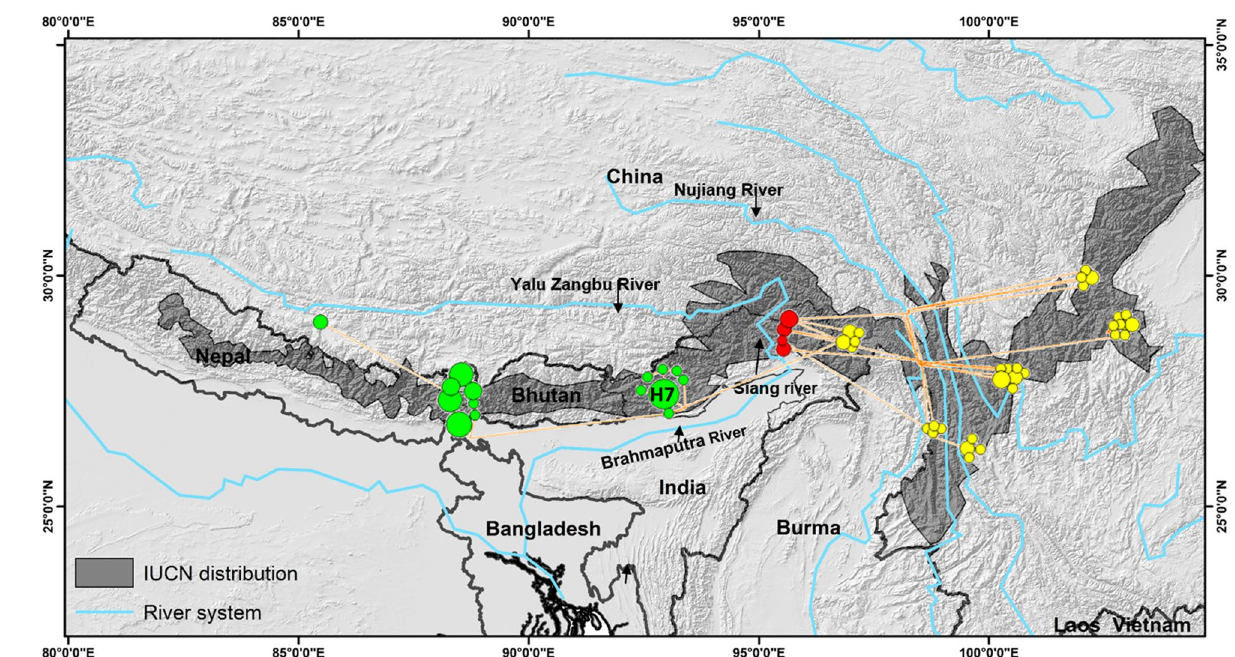
Figure 3. Distribution of haplotype with respect to the geographical origin of the samples in India and China. Green color dots represented Himalayan red panda, Yellow dots represented Chinese red panda (samples originated from the administrative boundary of China and red color represented Chinese red panda observed in the Dibang valley, Arunachal Pradesh, India). (Map generated using ArcGIS: https ://www.arcgi s.com/index